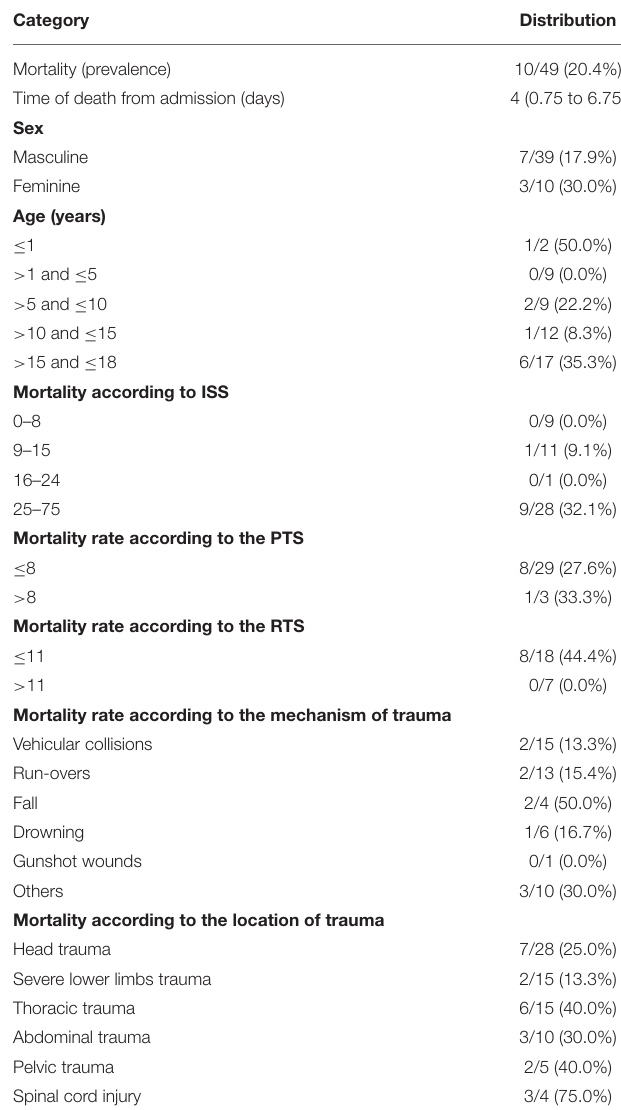
TABLE 3 | Distribution and description of mortality according to demographic data, severity, and mechanism and location of trauma.